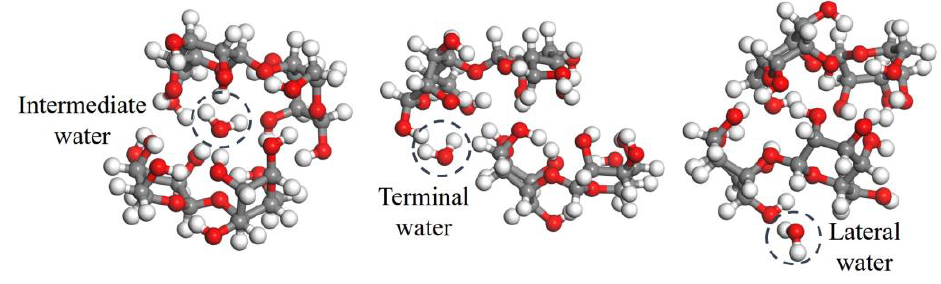
Figure 12. Three types of water – cellulose model with intermediate, terminal, and lateral water mol- ecule.